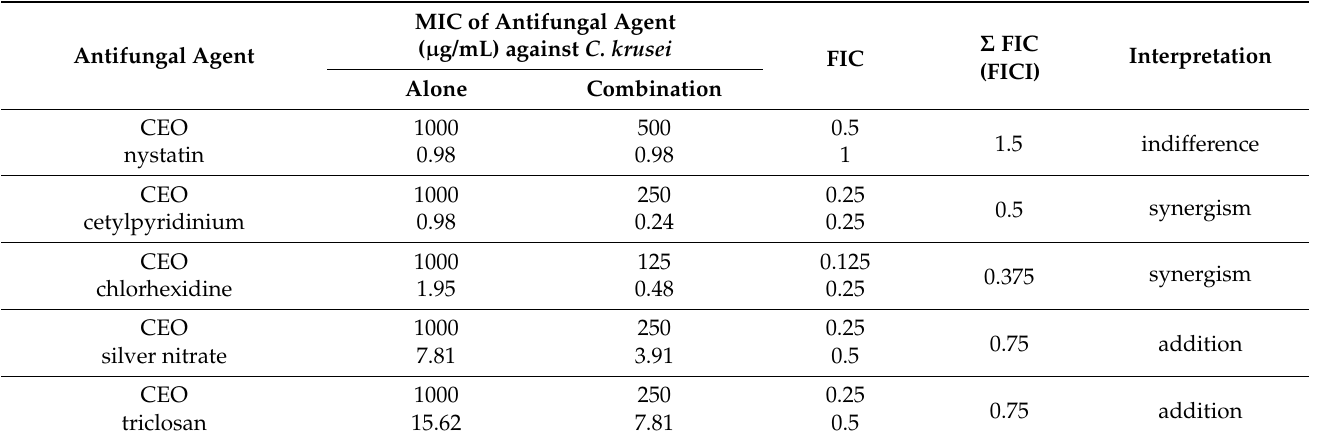
Table 7. MICs and FIC indices of CEO alone and in combination with selected antimycotics on reference C . krusei ATCC 14243 strain.